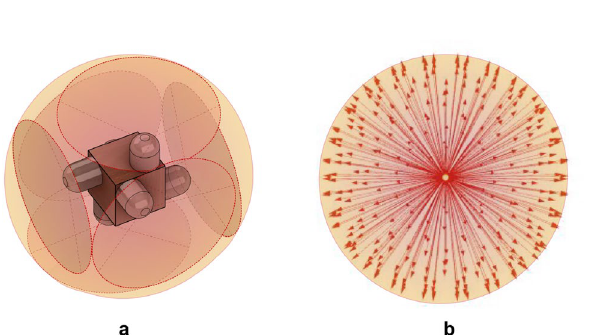
Figure 12. The experimental configuration in the chamber including the 6-sided ‘ground truth’ pyrgeometer measurement device on the wooden cube,large globe, gray and black ping pong balls, and air temperature and velocity probes.